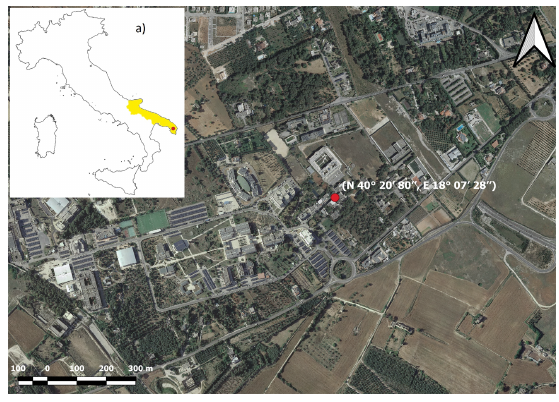
Figure 1. Map of the measurement area indicating the observation site (red circle) at the ECO observatory. In the inset “a)” is the location of the Apulia region (in